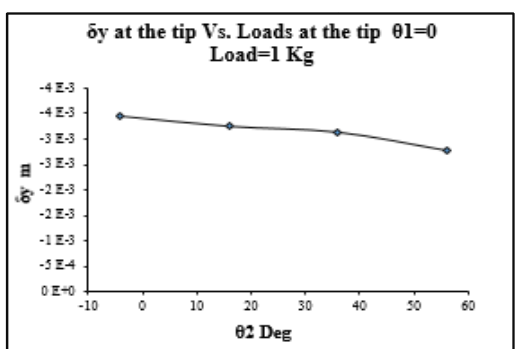
Fig.8 δ x Vs. θ 2 at θ 1=4 Deg. link